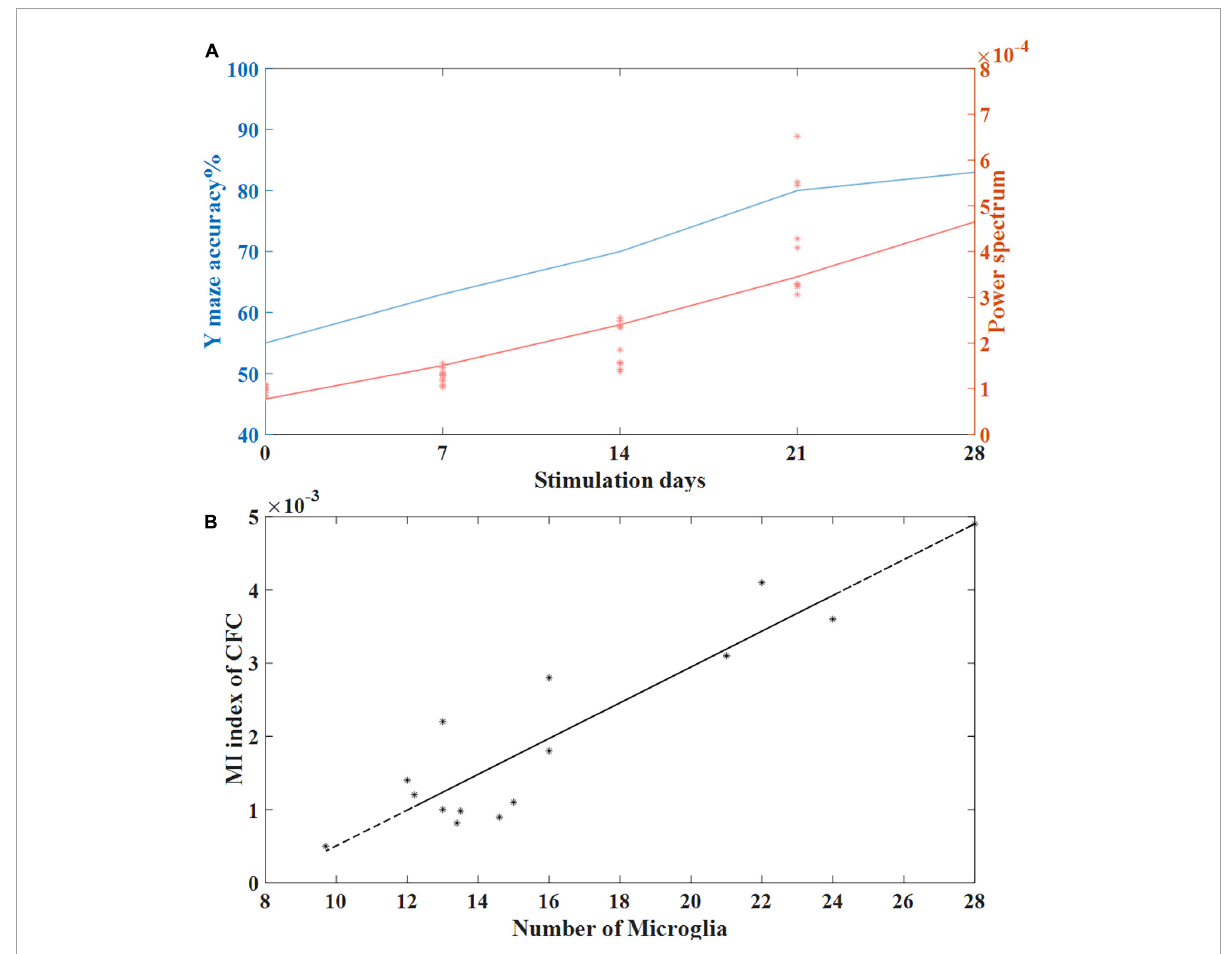
FIGURE8 (A) The relationship between stimulation time and behavioral accuracy and the relationship between stimulation time and spontaneous gamma power spectrum. (B) Correlation between the number of microglia and the MI index of CFC in the tACS treatment groups ( n = 20). The line is the best-fit linear regression (stars), with correlation r = 0.92 (Pearson, P <